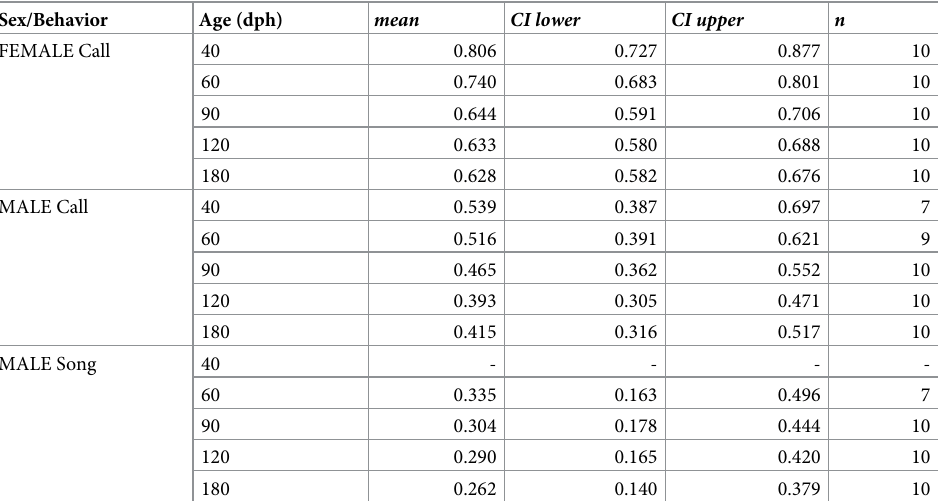
Table 3. The numerical description vocal response data shown in Fig 3A (call) and 3D (song).